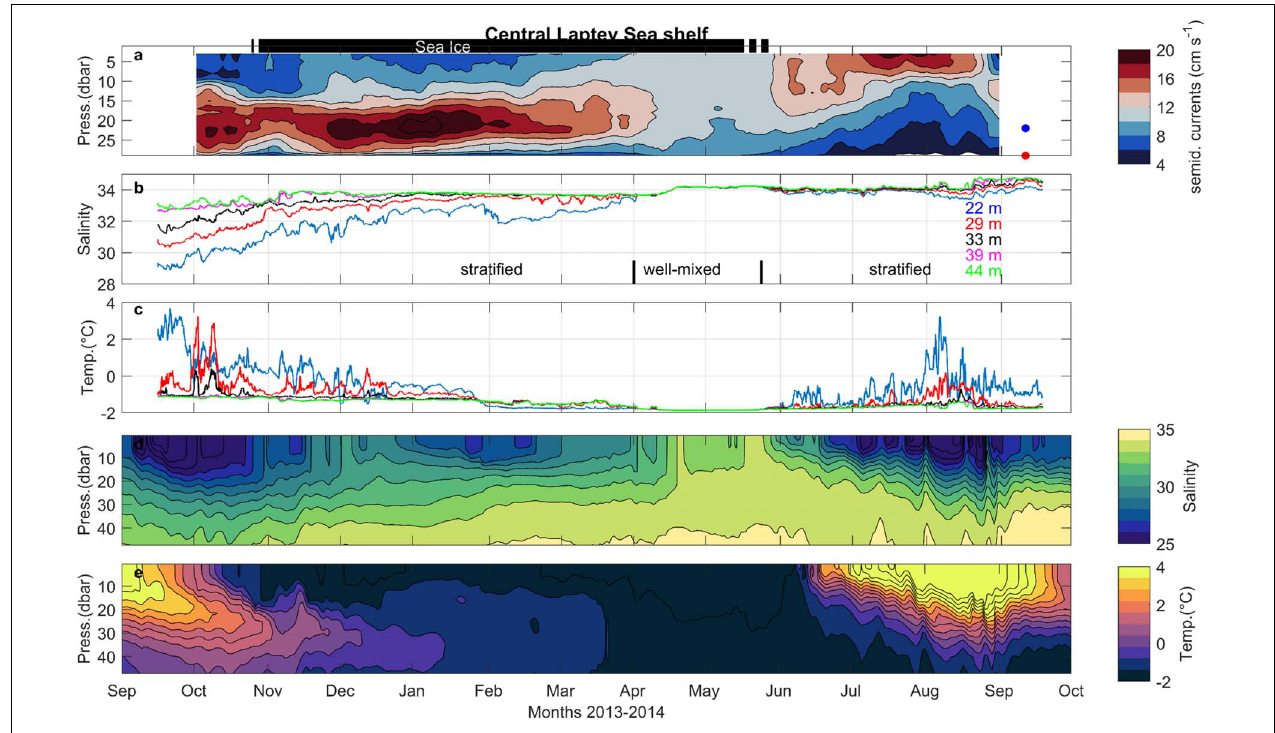
FIGURE 9 | Same as Figure 8 but for the Central –